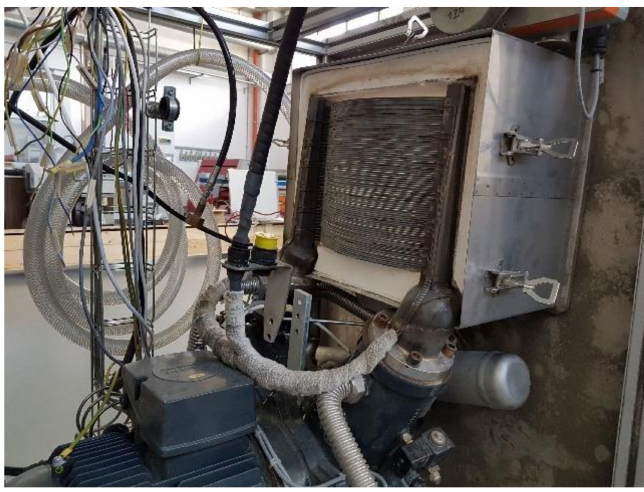
Figure 12. The Stirling motor